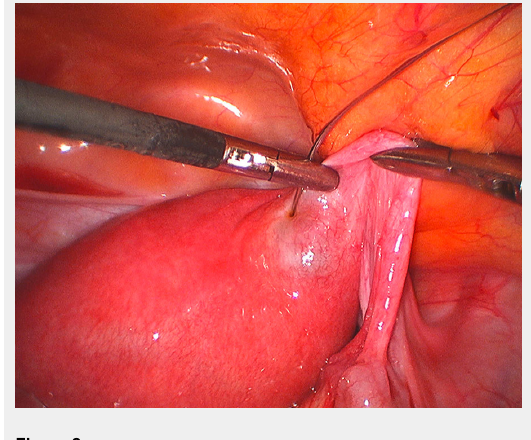
Laparoscopic intracornual MTX injection.